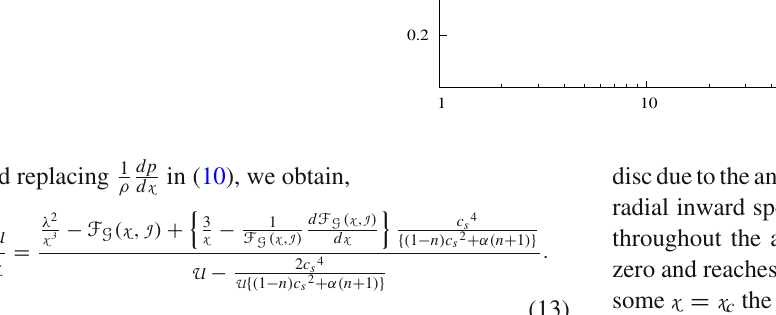
Accreting agent: Modified Chaplygin Gas Accretion branch with α ss =0 Accretion branch with α ss =10